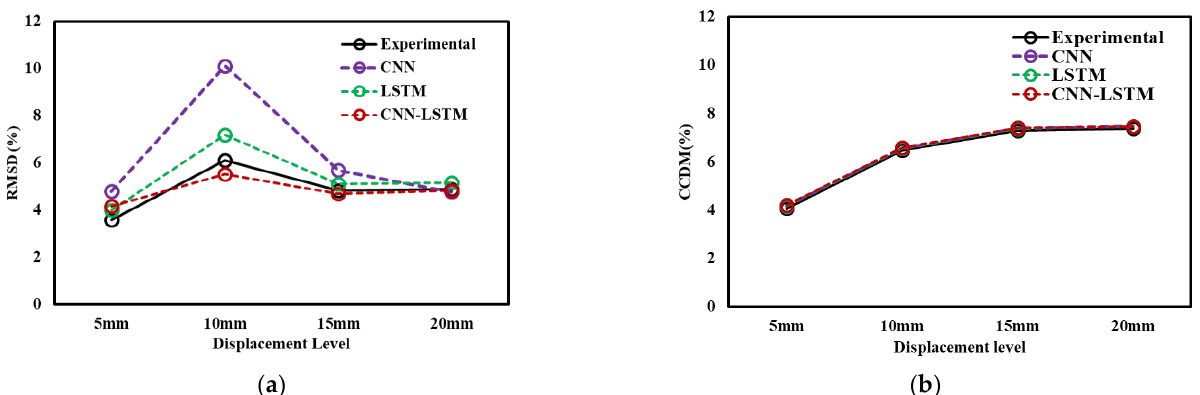
Figure 18. Comparison between experimental and predicted statistical indices ( a ) RMSD ( b ) CCDM.